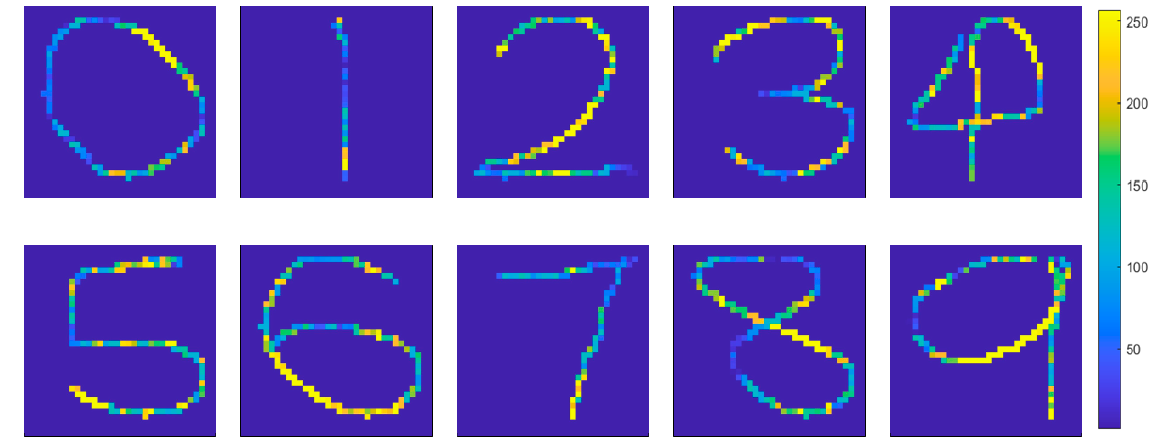
Figure 9. The trajectories of digits 0~9 with size of 28 ×